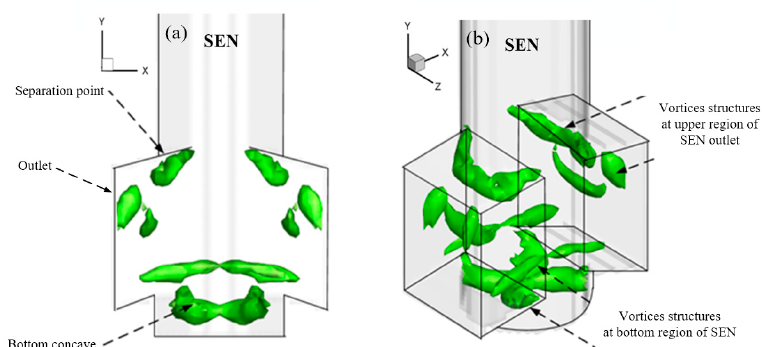
Figure 3. Distribution of the coherent structures inside the SEN from different views: ( a ) at the middle and ( b ) 3D perspective.